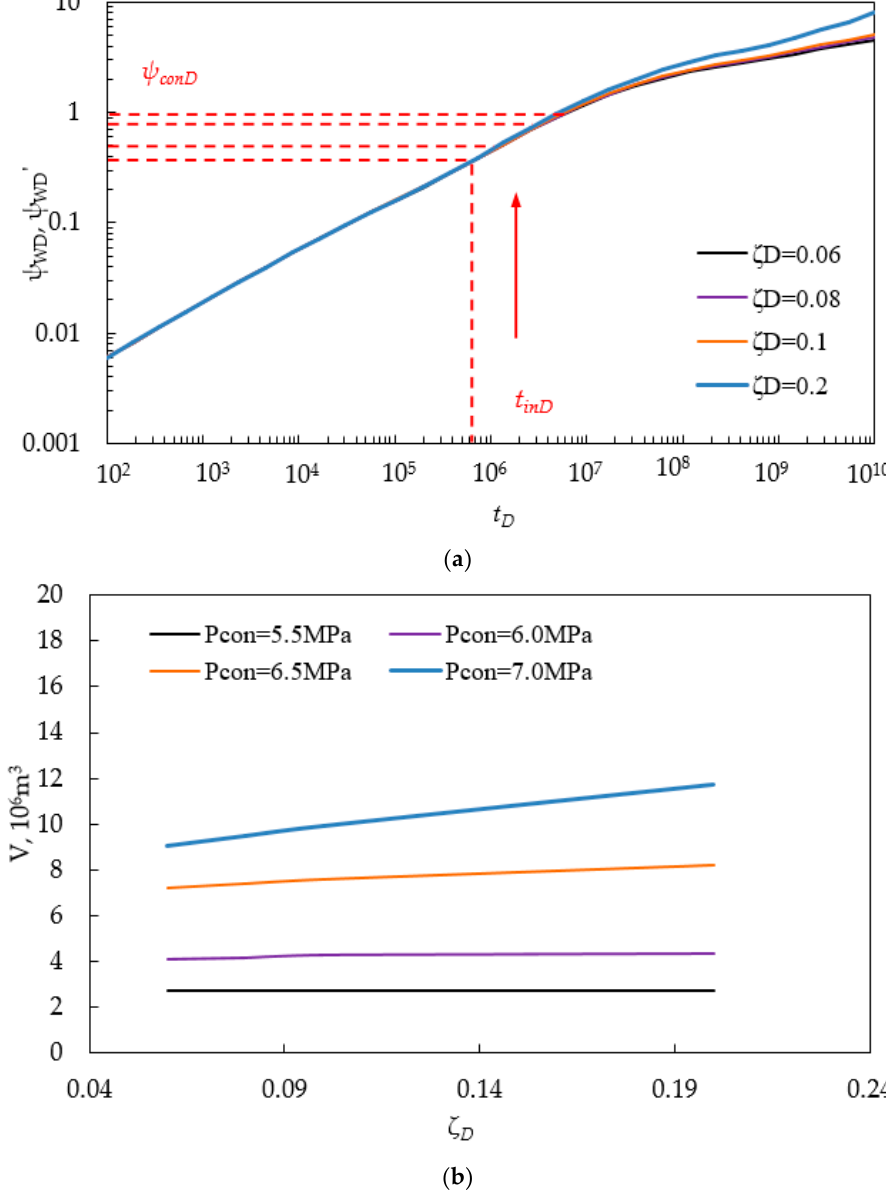
Figure 17. ( a ) Comparison pressure with different fracture number; ( b ) comparison of CO 2 storage capacity with different fracture number.